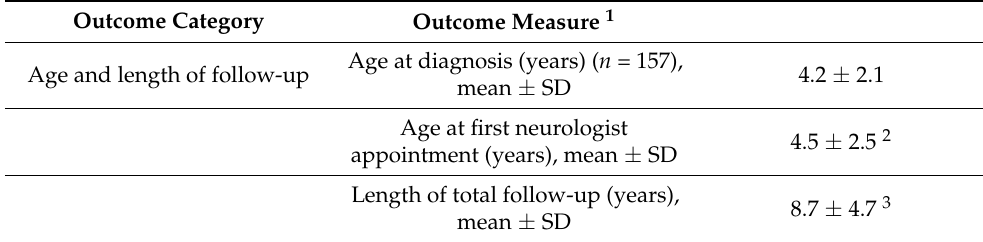
Table 2. Clinical Characteristics ( N =